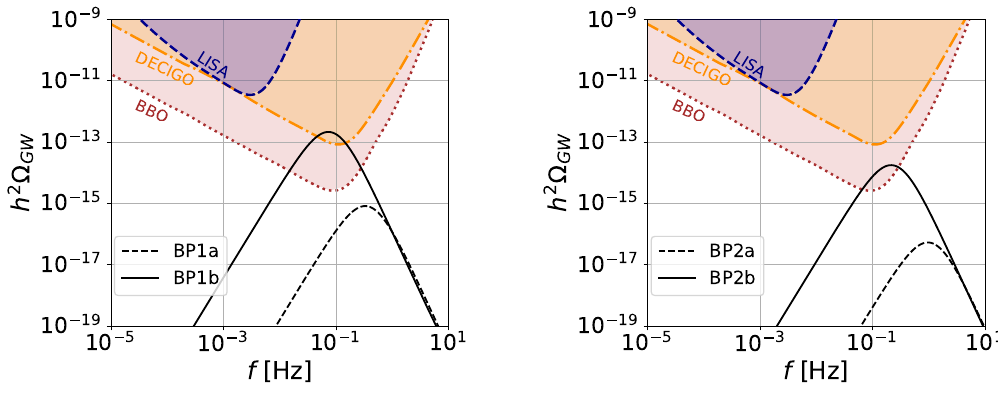
Figure 7 . The GW spectra calculated at the benchmark points in table 3. The purple, orange and red lines are the sensitivity curves of LISA, DECIGO, and BBO. The black solid and dashed lines are the GW spectra which are produced by the first order phase transition in these points.